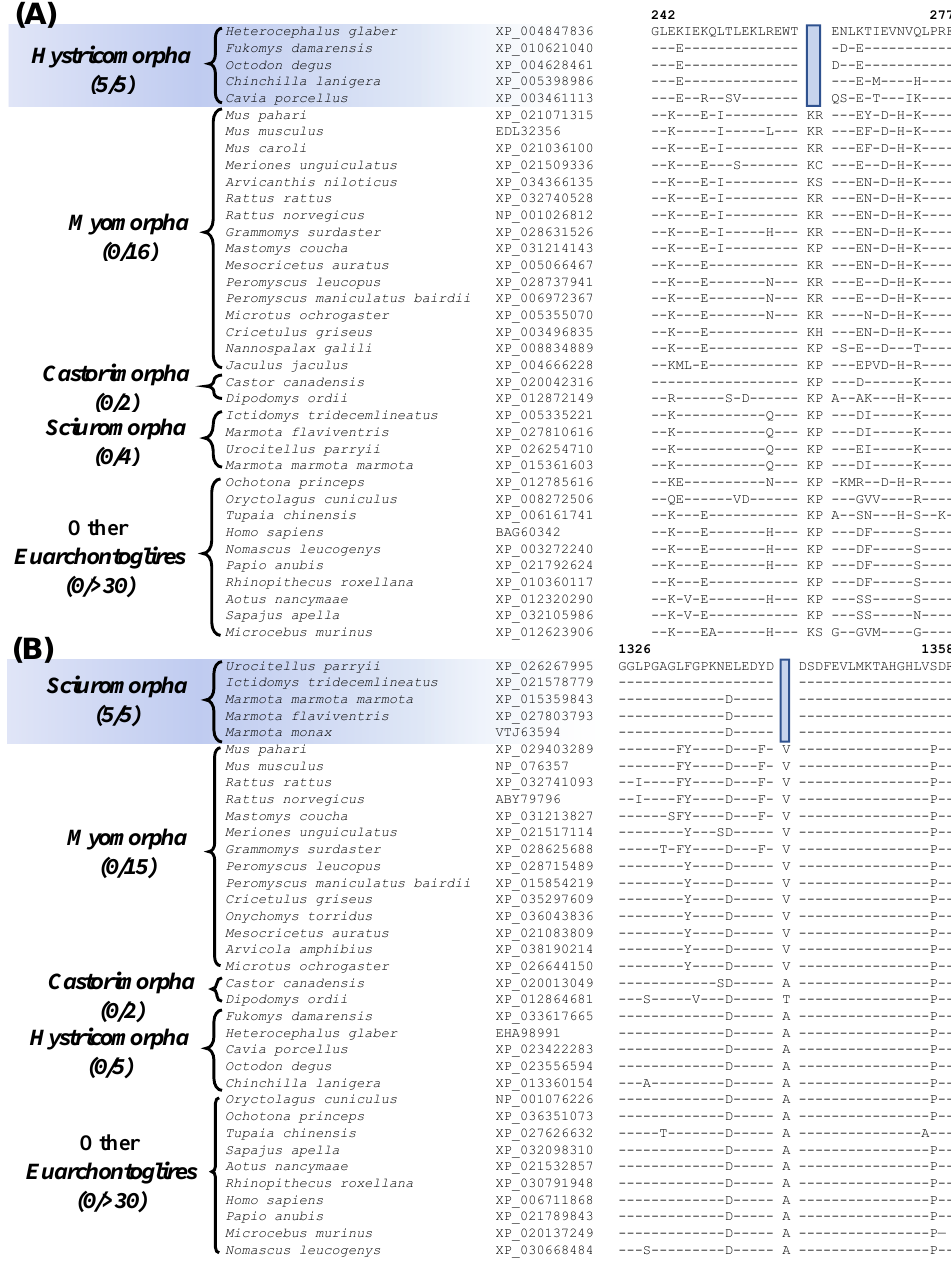
Figure 5. Partial sequence alignment of ( A ) the protein leukocyte elastase inhibitor A containing a 2 aa deletion that is specific for members of the suborder Hystricomorpha, and ( B ) excerpts from the sequence alignment of the protein ryanodine receptor 2 containing a 1 aa deletion that is specific for the suborder Sciuromorpha. Other details are the same as described in legend of Figure 1. Sequence information for other CSIs specific for the suborders Hystricomorpha and Sciuromorpha are provided in supplemental Figures S15–S29 and some characteristics are summarized in Table